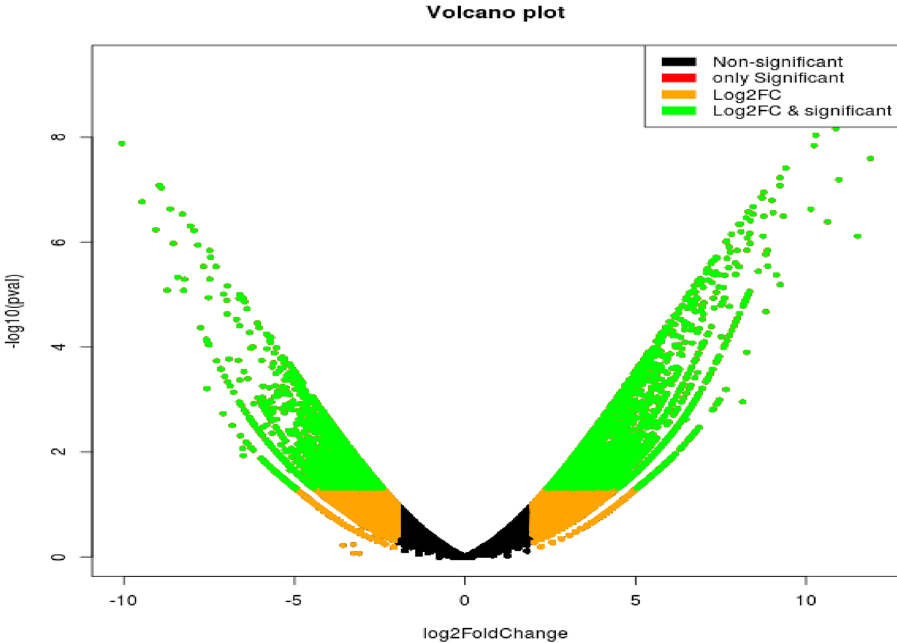
Figure 1. Analysis of differentially expressed genes (DEGs) in wheat flag leaf represented by volcano